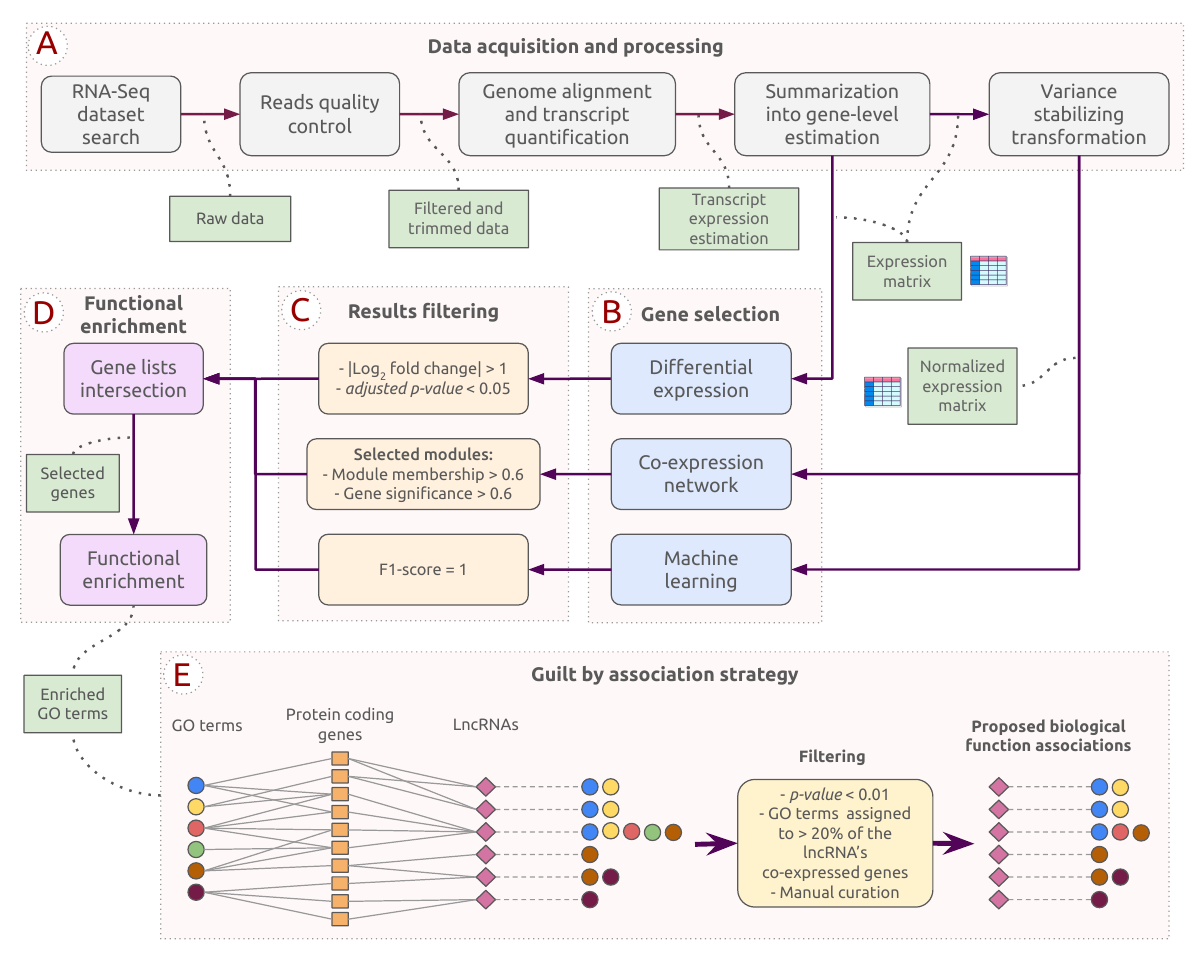
Figure 1. Pipeline representing the analyses performed in this study, including the following steps: ( A ) Data acquisition and processing; ( B ) Gene selection; ( C ) Results filtering; ( D ) Intersection and functional enrichment analysis; and ( E ) Guilt by association